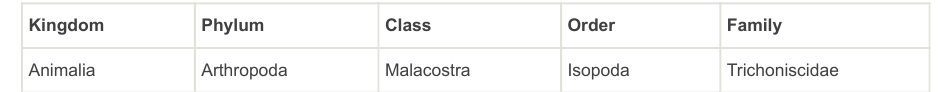
Kingdom Phylum Class Order Family Animalia Arthropoda Malacostra Isopoda